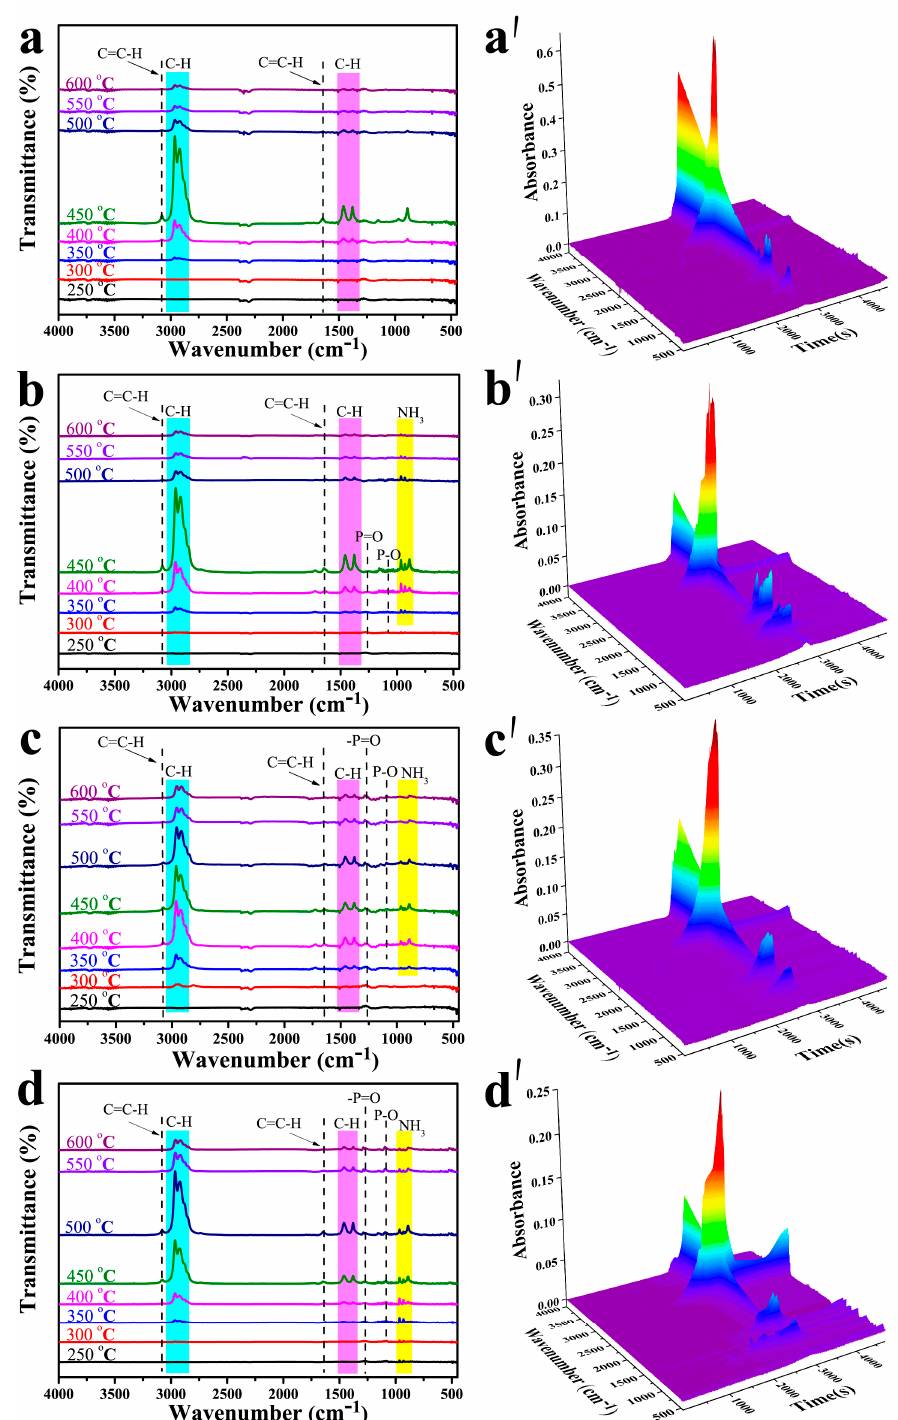
Figure 6. FTIR spectra and 3D TG-FTIR of the pyrolysis products of PP0 ( a , a ′ ), PP1( b , b ′ ), PP3 ( c , c ′ ) and PP6 ( d , d ′ ) at different temperatures.